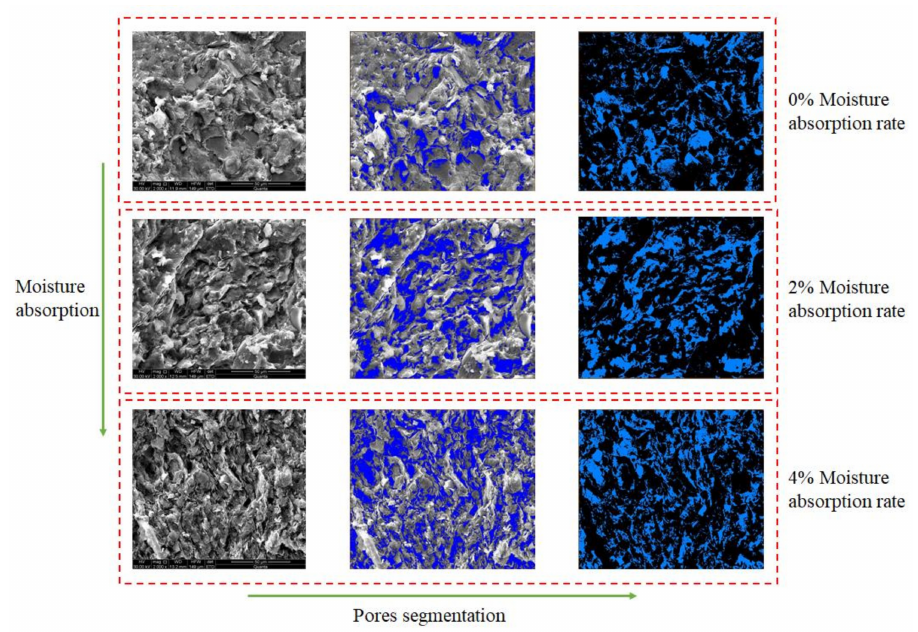
Figure 13. The process of pores